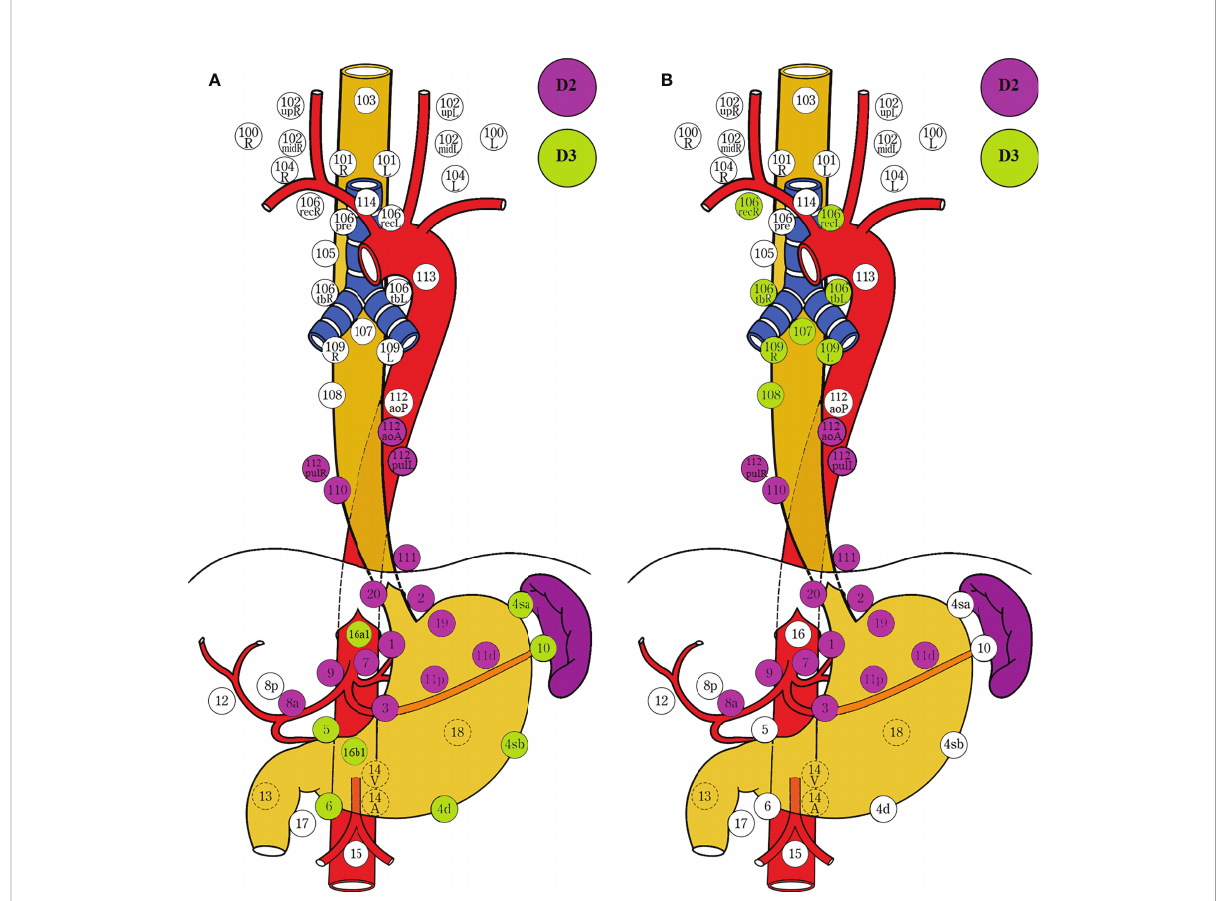
FIGURE 5 Obligatory and optional stations for lymph node dissection determined by the epicenter location and tumor extension in the stomach- predominant tumor (A) and esophagus-predominant tumor (B) . EI-1 and EI-2 nodes with EI exceeding 2% are designated as obligatory stations, while EI-3 nodes between 0.5% and 2% are designated as optional stations. The obligatory lymph nodes around the upper perigastric, lower mediastinal, and suprapancreatic zones should be resected in any case. The epicenter location has a greater impact on the metastasis at the obligatory stations. In contrast, tumor extension has a more important role on the metastasis at the optional stations. Lower perigastric and paraaortic nodes should be resected in the stomach-predominant tumor with gastric involvement exceeding 5.0 cm, and splenic hilar nodes